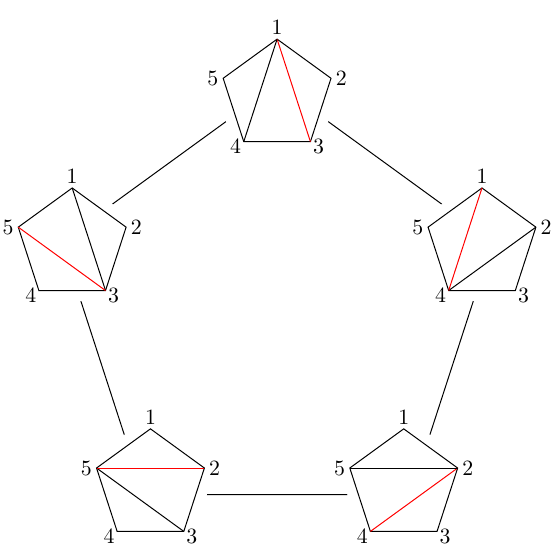
Figure 1. All possible triangulations of the pentagon. Mutating on the red chord moves you clockwise around the